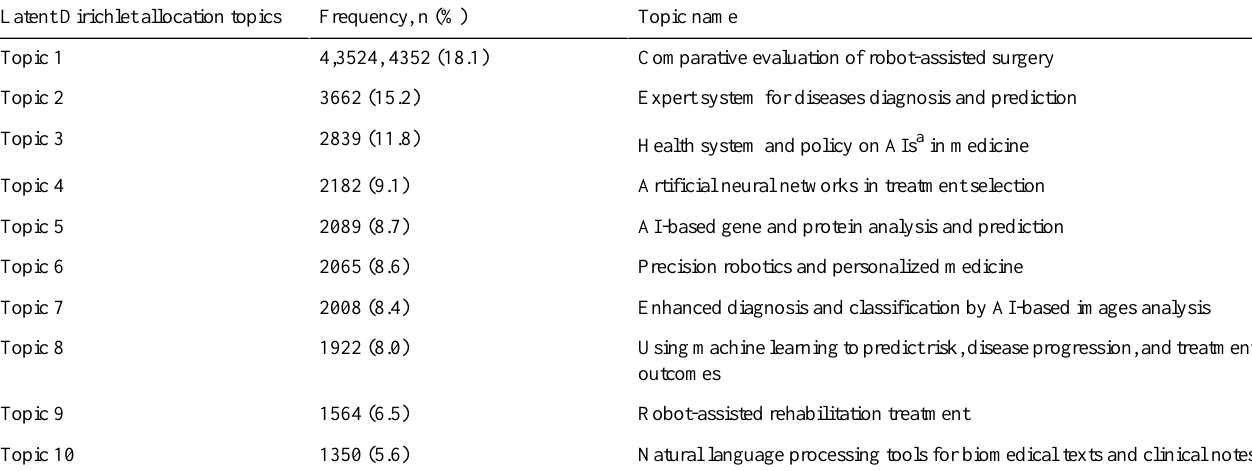
Table 4. Ten research topics classified by latent Dirichlet